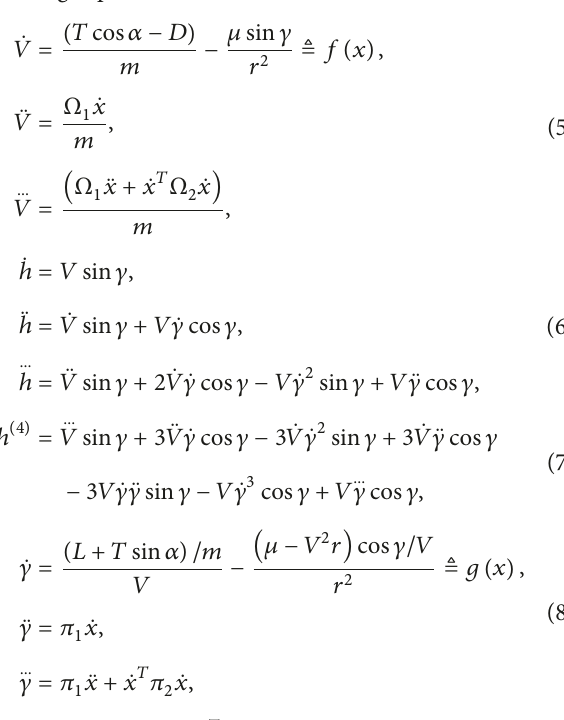
For the quasi-continuous HOSM controller (11), the design parameters 𝛼 𝜉𝑖 and 𝛽 𝜉𝑖𝑗 (𝑖 = ℎ, V , 𝑗 = 1, 2, . . .)